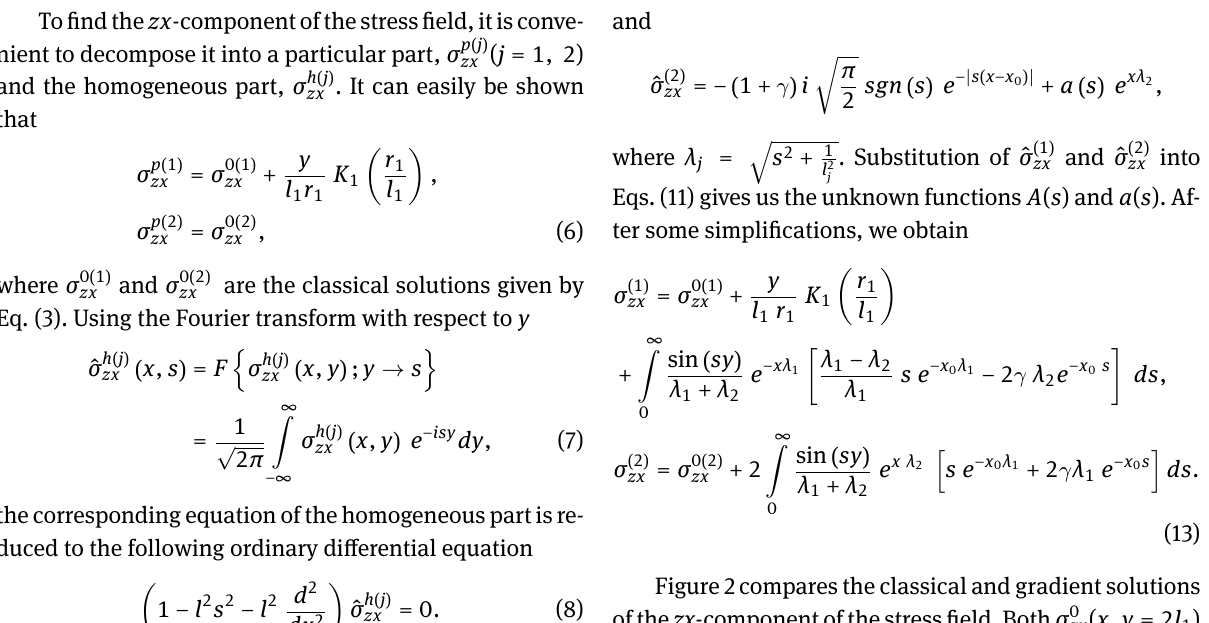
Figure 2 compares the classical and gradient solutions of the zx -component of the stress field. Both σ 0 zx ( x , y = 2 l 1 ) and σ zx ( x , y = 2 l 1 ) are continuous across the interface. Unlike σ 0 zx ( x , y = 2 l 1 ), σ zx ( x , y = 2 l 1 ) is also smooth at the interface.